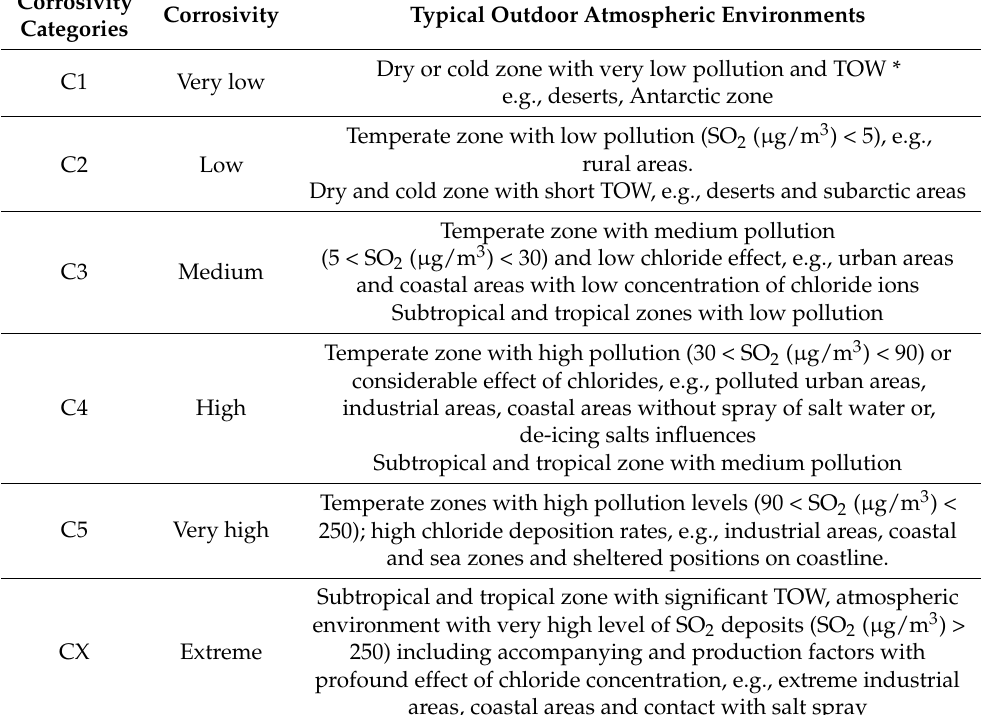
Table 1. Different corrosivity categories based on ISO9223